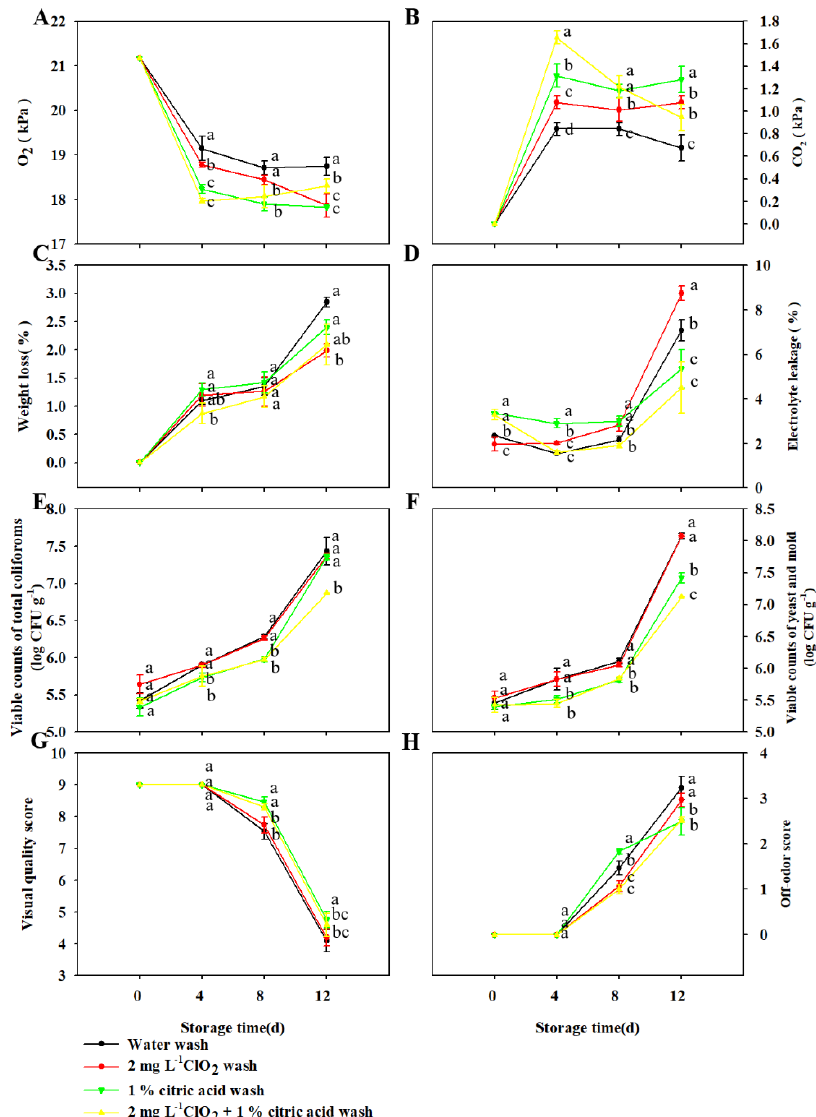
Figure 3. Effect of wash treatment on the changes in O 2 ( A ) and CO 2 ( B ) partial pressures within packages, weight loss ( C ), electrolyte leakage ( D ), counts of total coliforms ( E ) and yeast and mold (Y&M) ( F ), overall quality score ( G ) and off-odor score ( H ) of TBM packed by LDPE bags during 5 °C storage. The vertical bar represents ± standard error. Significant differences between samples (within the same time point) are indicated with different lowercase letters above the plots.